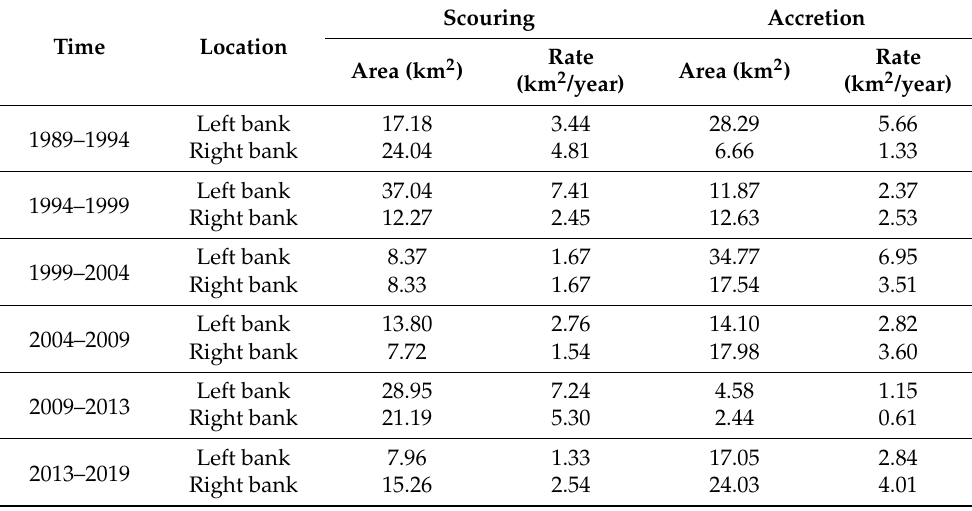
Table 5. Scouring and accretion on the left and right banks,